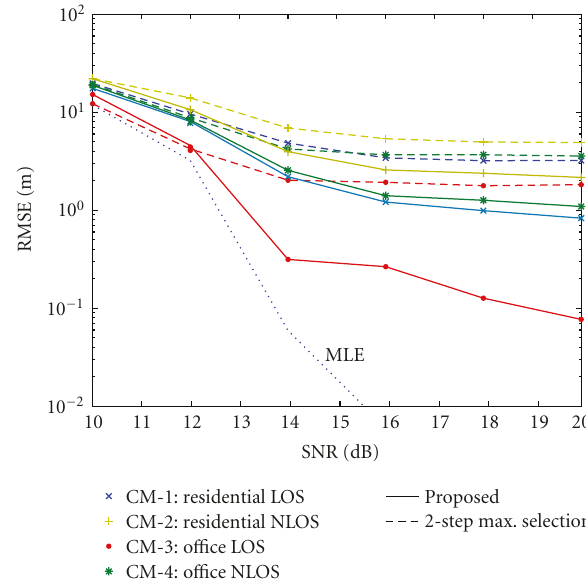
Figure 7: RMSE versus SNR for the proposed and the two-step peak selection